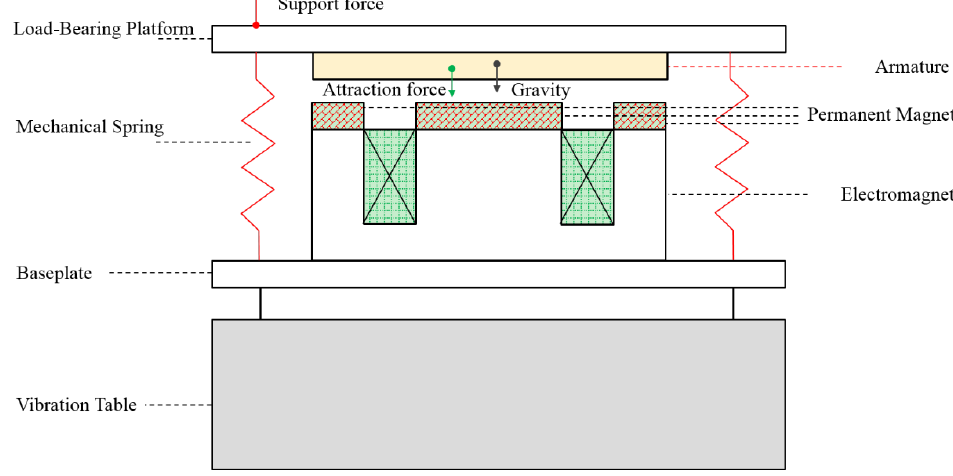
Figure 1. The overall structure of the PECVIS.